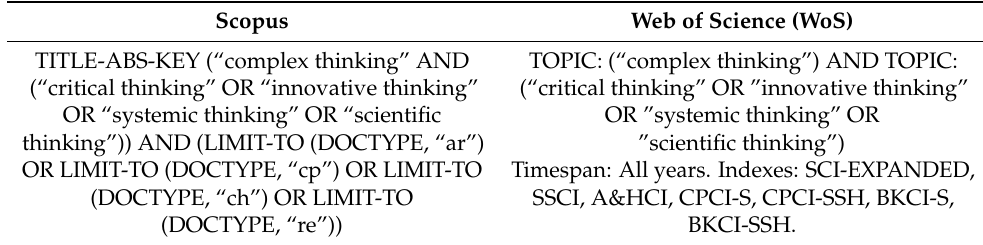
Table 2. Search strings used in the indexing systems.